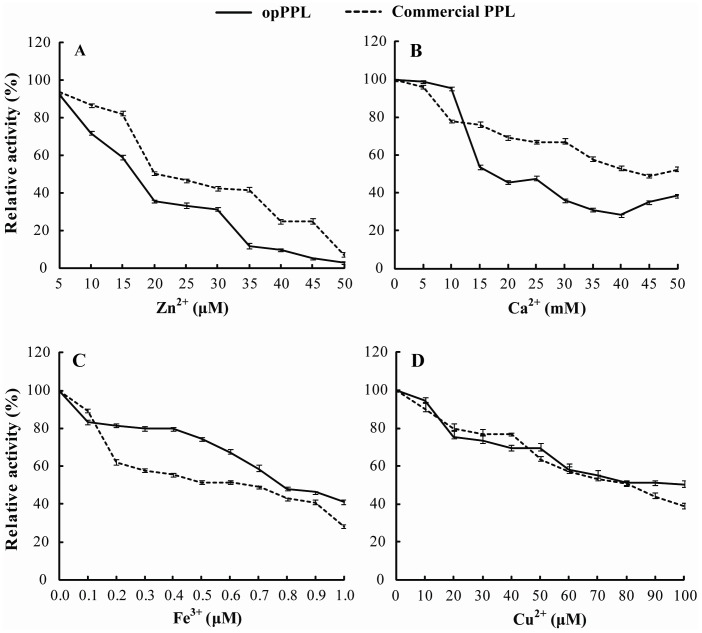
Effect of metal ions on opPPL and commercial PPL activity.(A),(B),(C) and (D) represent the effect of Zn2+, Ca2+, Fe3+ and Cu2+ on the activity of opPPL and commercial PPL, respectively. y means relative enzyme activity; x means concentration of the metal ions; These assays were performed as described in Materials and methods using 10.0 mM p-NPP as substrate(n = 3). The maximum value was taken as 100%.